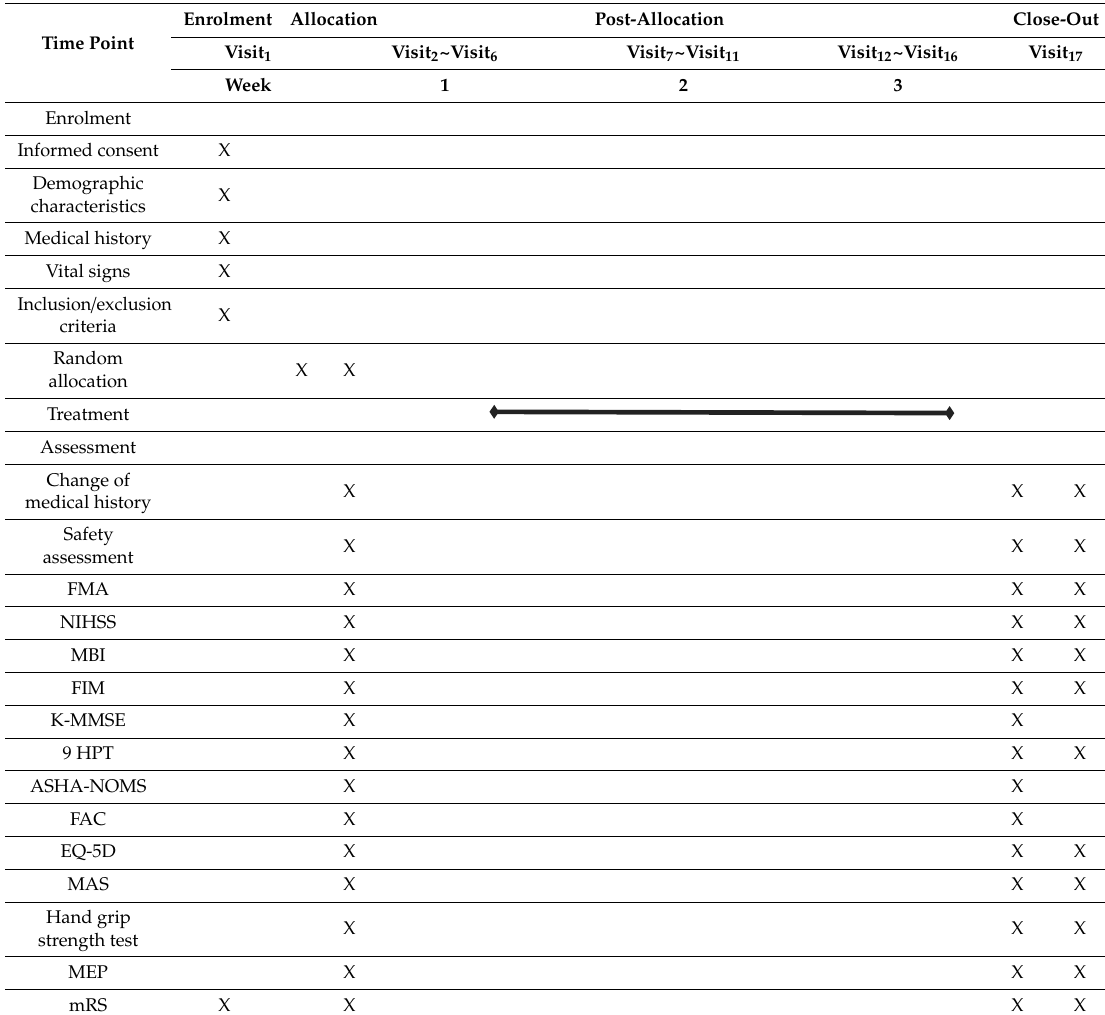
Table 1. Enrolment, intervention, and data collection protocols.